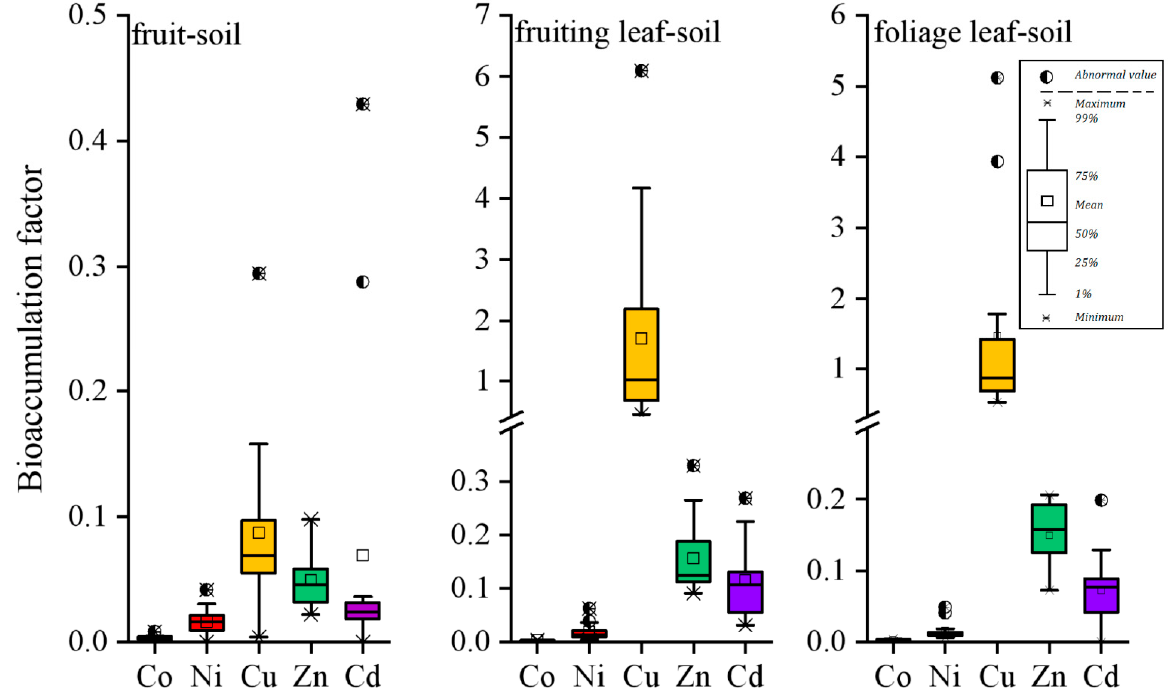
Figure 6. Bioaccumulation factor (BAF) of heavy metals in fruit, fruiting leaf and foliage